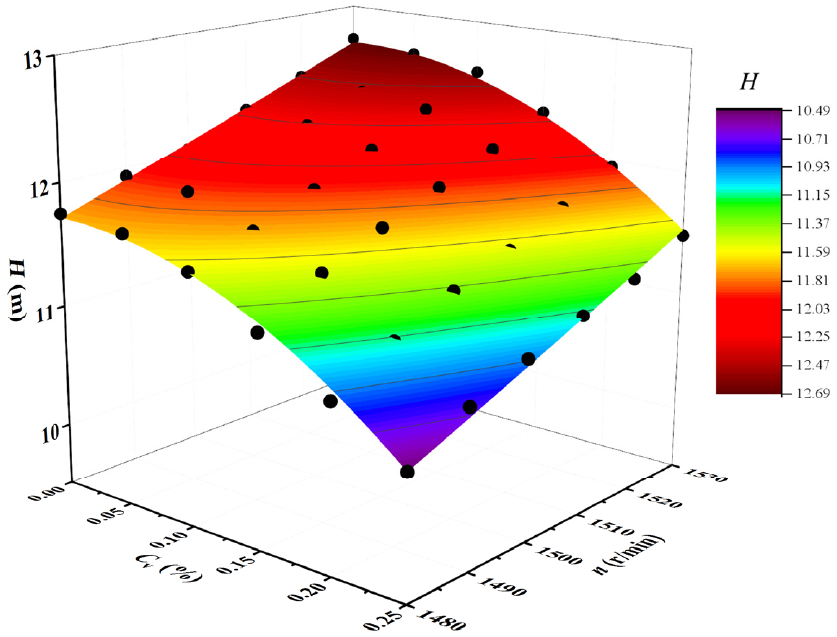
Figure 15. Three-dimensional fitting surface of different solid volume concentrations and speeds.